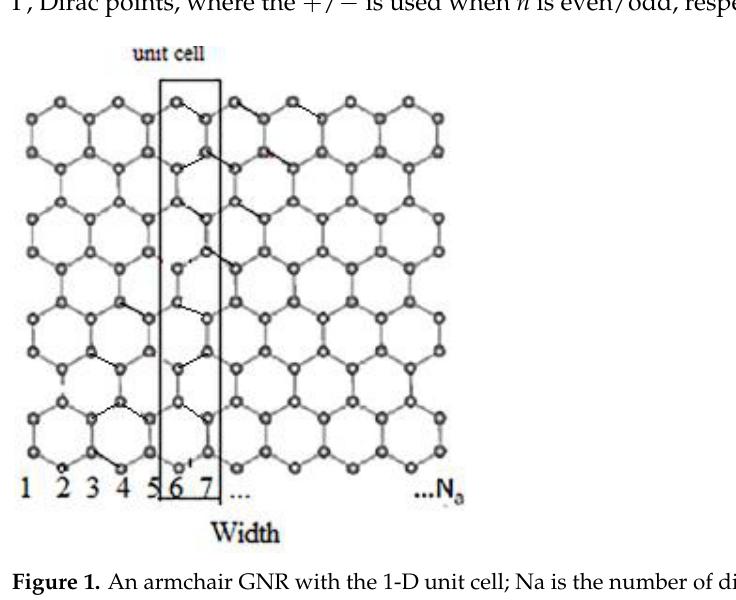
Figure 1. An armchair GNR with the 1-D unit cell; Na is the number of dimer